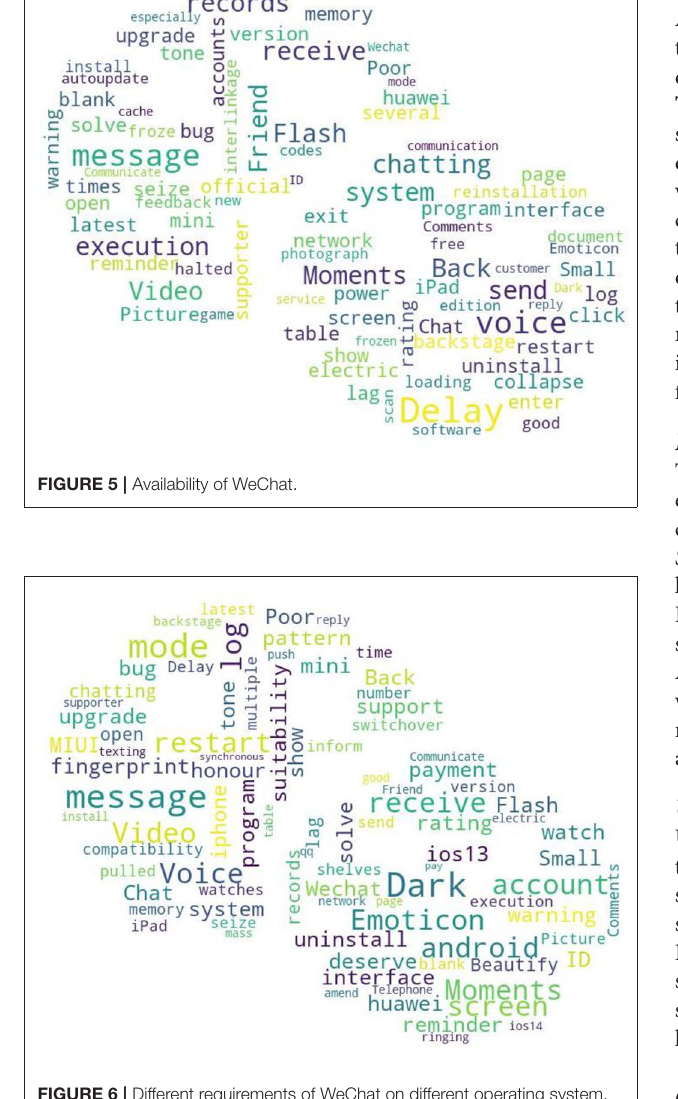
psychology to some of the functionalities of WeChat APP, thereby forming negative emotions, which affect the download behavior of WeChat users. At this time, the negative emotions of users brought about by the different needs of different systems are often an aspect that enterprise developers tend to ignore. Here, the negative comments brought about by the different needs of different systems are screened out, word frequency analysis is performed, and a word cloud diagram is drawn. The result is shown in Figure 6 , which indicates that the differences in user needs of WeChat APP due to different systems mainly result from the difference in background mode (dark mode), the difference in experience of crashing, and the difference in the functionality of modifying the WeChat